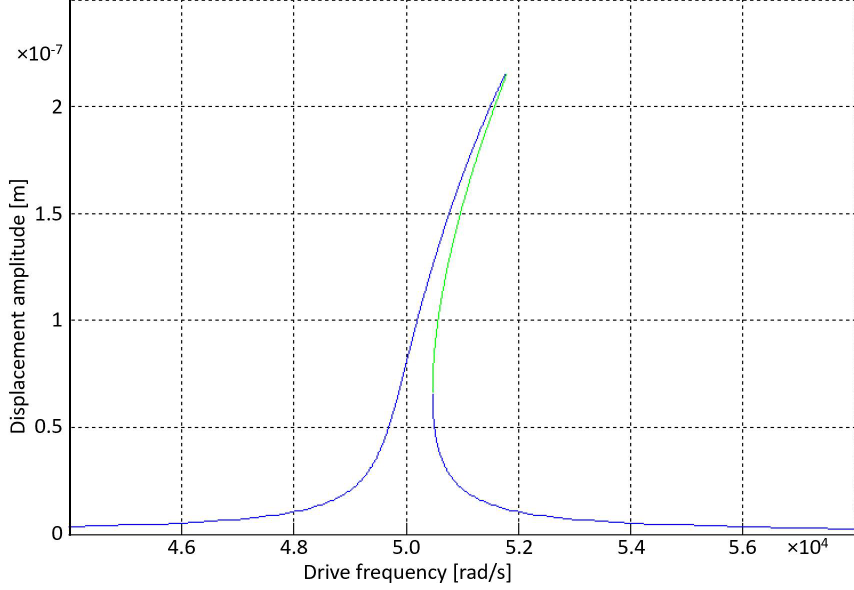
.. . Figure 6. Nonlinear frequency response of Figure 6. Nonlinear frequency response of M x + D x + Kx + ( κ + κ e ) x 3 = F 0 cos ( ω t ) , where M = 8 × 10 − 10 kg, D = 1.55 × 10 − 7 Ns/m, K = 2 N/m, κ = 4 × 10 10 N/m 3 , κ e = 4 × 10 12 N/m 3 , and F 0 = 1.7 × 10 − 9 N due to a driving voltage of V 0 = 0.9 V. Note that κ e is two orders larger than